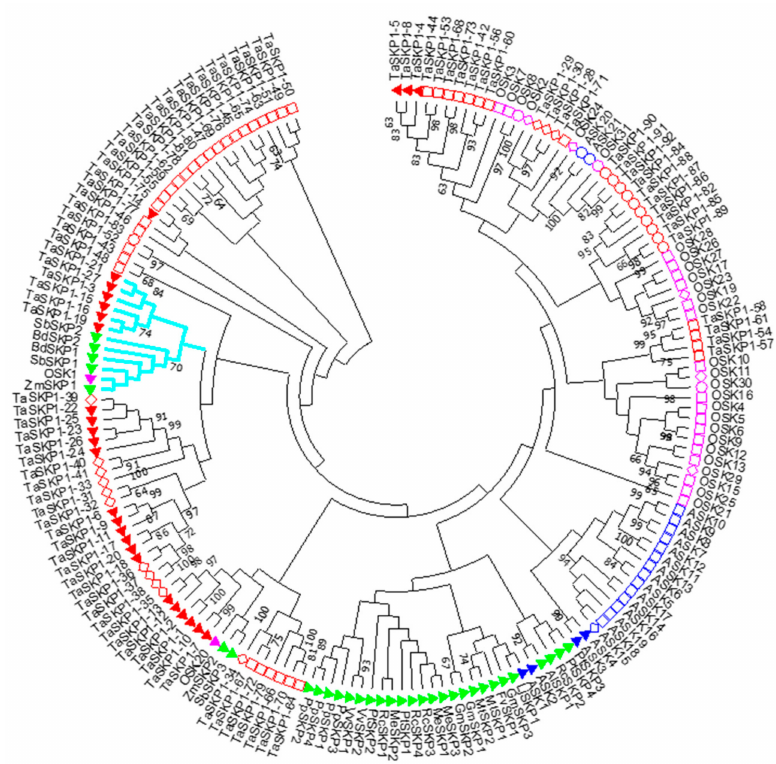
Figure 2. Phylogenetic tree of SKP1-like genes in wheat based on the alignment of the amino acid sequences of 174 SKP-like genes from moss, monocot and eudicot species comprising 92 T. aestivum TaSKP1-like genes ( TaSKP1_1 through TaSKP1_92 in red), 4 P. patens genes denoted PpSKP ( PpSKP1 through PpSKP4 in green), 21 Arabidopsis thaliana ASK genes ( ASK1 through ASK21 in blue), 29 Oryza sativa genes ( OSK1 through OSK31 in purple; two of which are no longer included in this denomination). A set of 28 additional SKP1-like genes from various plant species with a single position-conserved intron was included ( ZmSKP from Zea mays , SbSKP from Sorghum. bicolor , MtSKP from Medicago truncatula , RcSKP from Ricinus communis , PtSKP from Populus trichocarpa , GmSKP from Glycin max , VvSKP from Vitis vinefera , BdSKP from Brachypodium distachyon , LjSKP from Lotus japonicus , AlSKP from Arabidopsis lyrata , MeSKP from Medicago esculenta ). The clade colored in blue